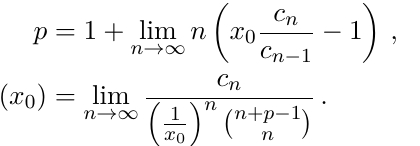
, we separate the 0